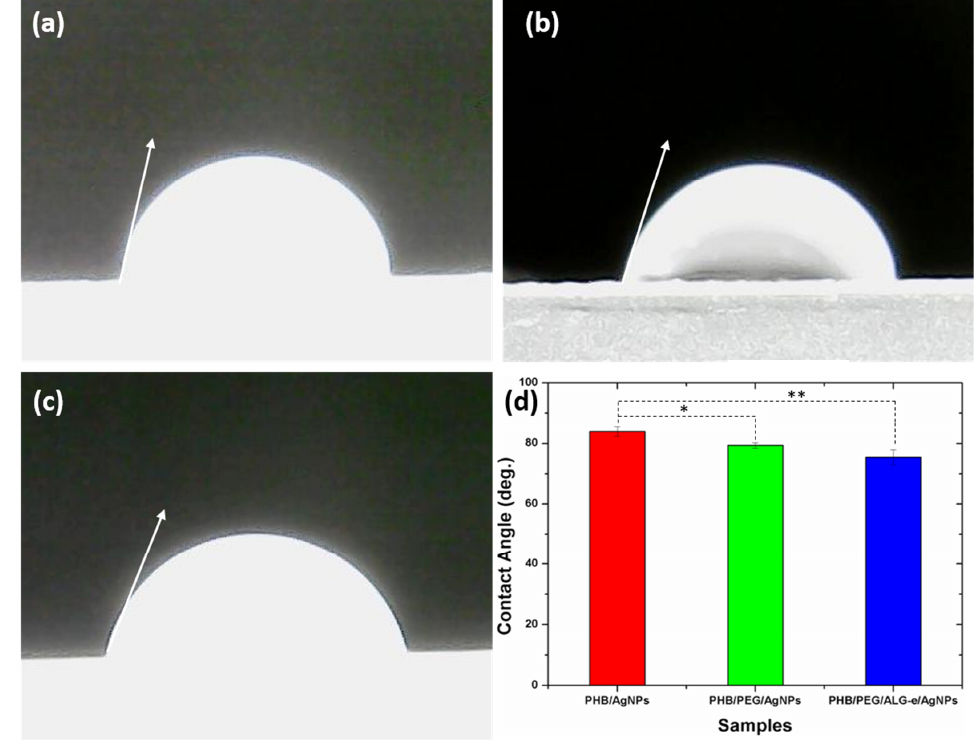
Figure 7. Representative contact angles of ( a ) PHB/AgNPs, ( b ) PHB/PEG/AgNPs, and ( c ) PHB/PEG/ALG-e/AgNPs and ( d ) their plotted average values. * and ** mean that there was statistical difference between the samples with significance level p < 0.05 or p < 0.01, respectively.